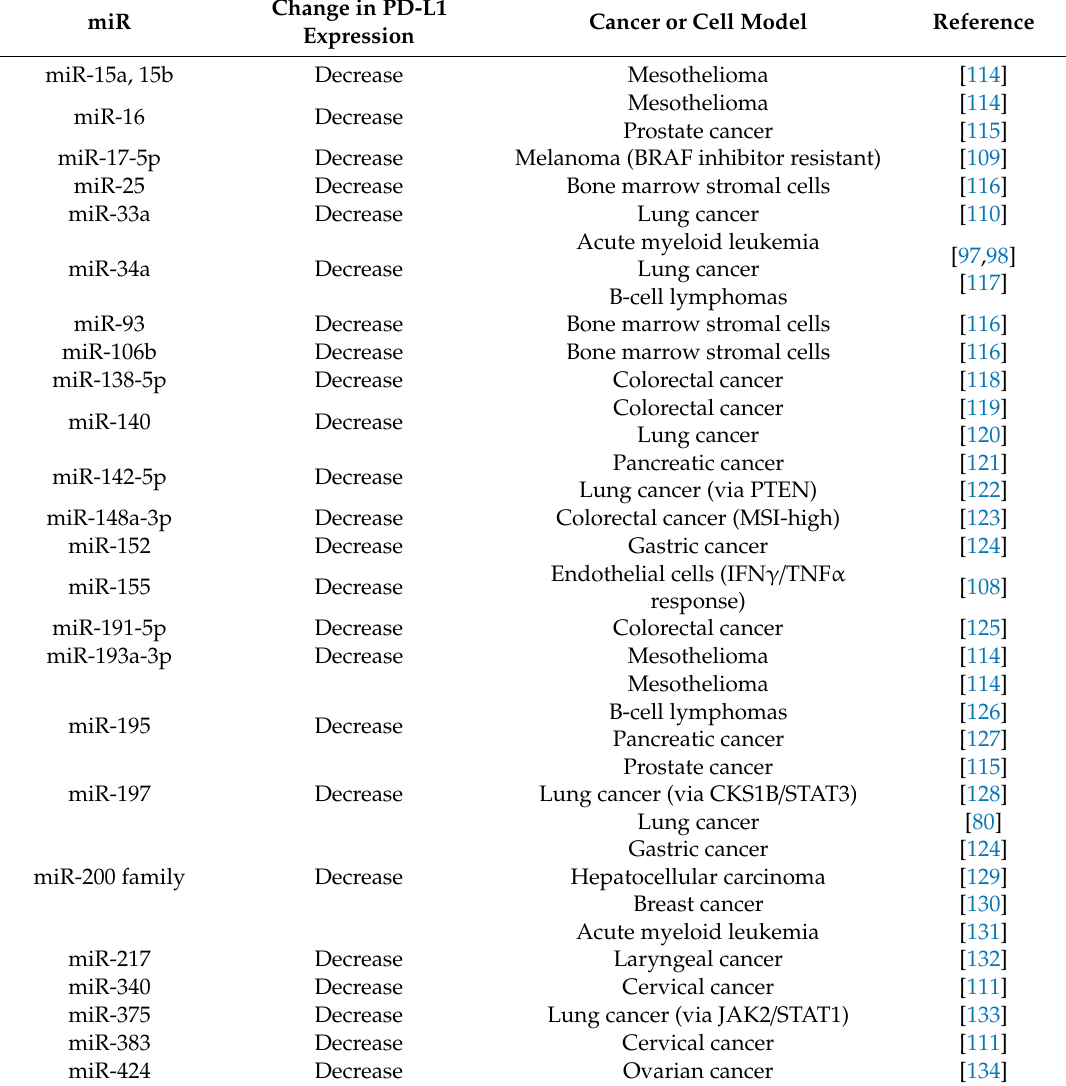
Table 1. MiR regulation of PD-L1